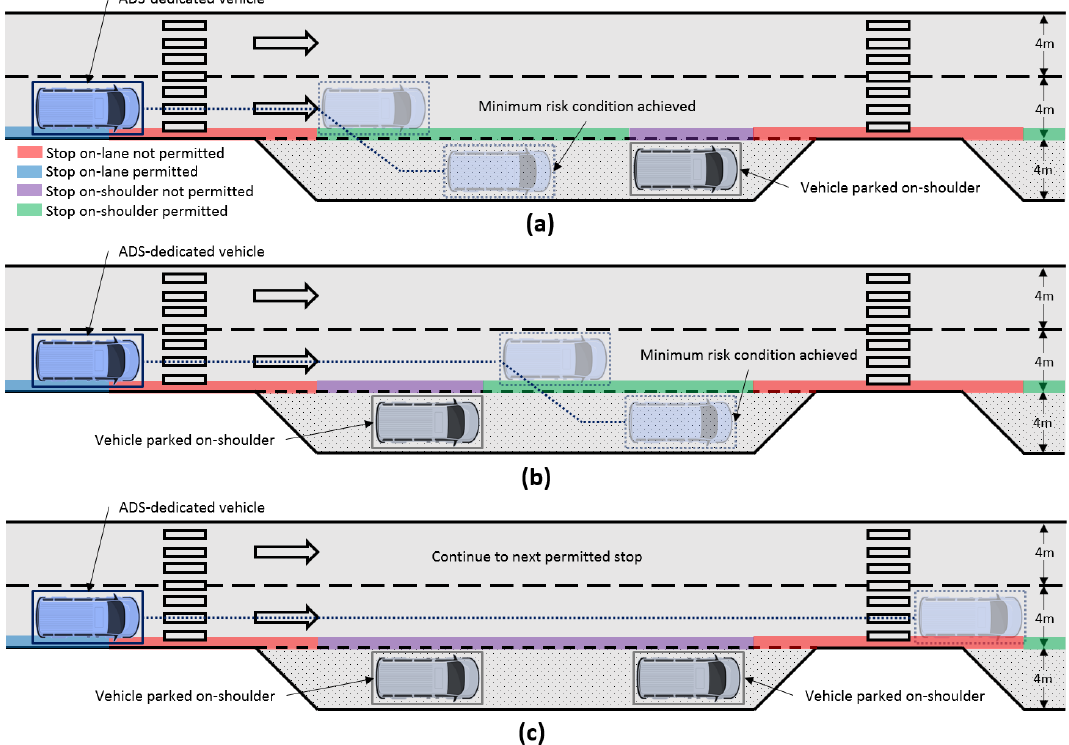
Figure 7. DDT fall-back strategy response under three different scenarios. A minimum risk condition is achieved ( a ) before and ( b ) after an object parked on the emergency shoulder. A next permitted stop necessary due ( c ) no space available on current emergency